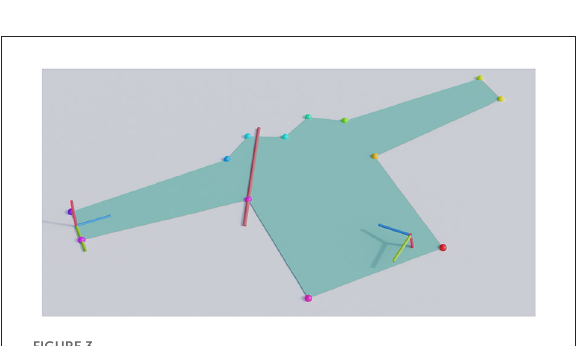
FIGURE3 An example fold specification for a sleeve fold on a long-sleeved shirt. The colored dots on the contour of the shirt denote the semantic keypoints. The red line shows the desired fold line. The RGB-colored axes on the left represent the gripper start pose, and those at the right the gripper end pose. The blue axis denotes the forward direction of the